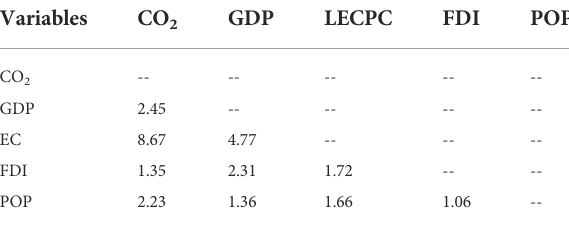
TABLE 2 Variance in fl ation factor (VIF) matrix.